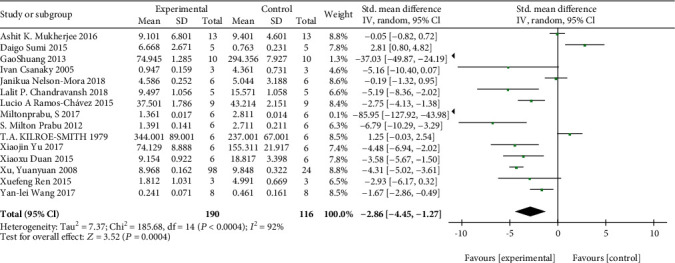
Meta-analysis of the effects of arsenic exposure on GSH in vivo. The forest plot shows the effect of arsenic treatment on GSH in the experiment and control group. SMD: standardized mean difference; IV: independent variable; 95% CI: 95% confidence interval; SD: standard deviation. The P value of the overall test effect is 0.00001; when P < 0.05, the difference was considered statistically significant.